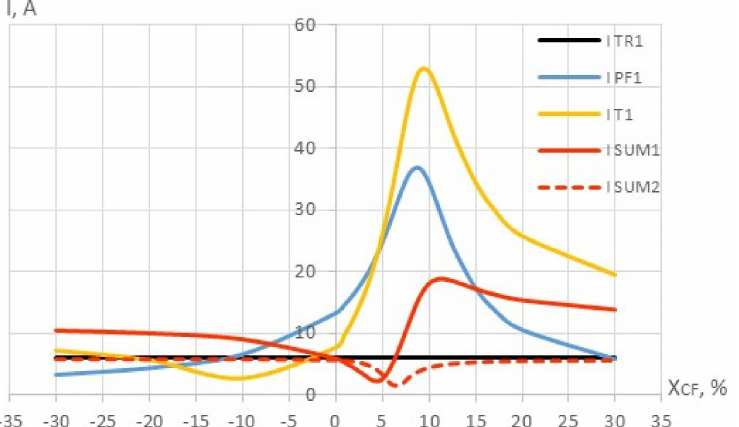
Figure 9. The dependences of the 5th harmonic currents I TR1 , I T1 , I PF1 , I SUM1 , I SUM2 on the passive filter capacitance X CF (simulation 5).